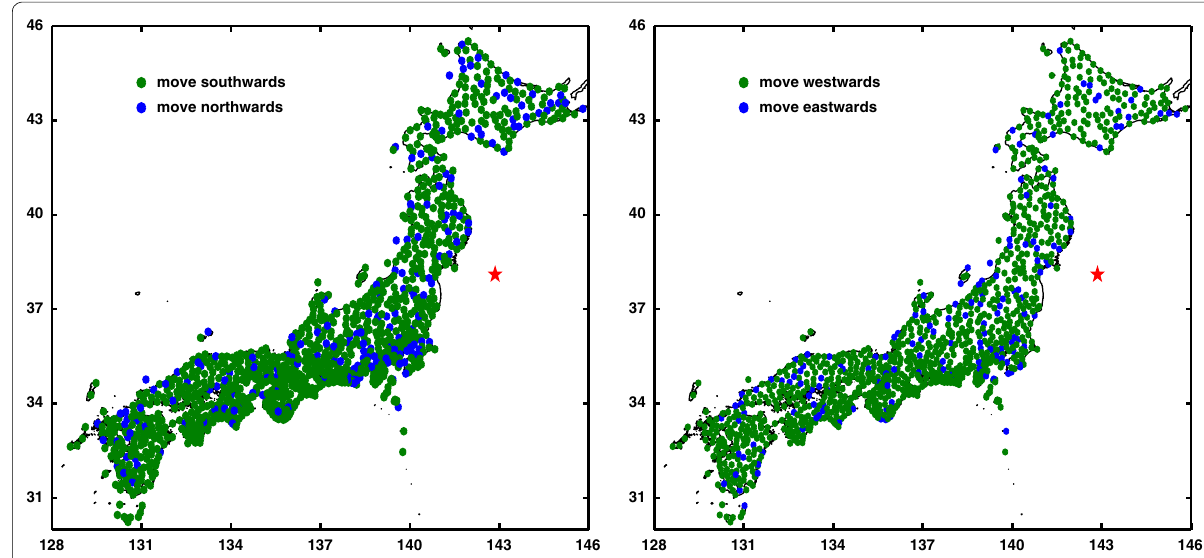
Fig. 8 The patterns of the movements of 1198 GEONET stations within 1 s: left panel—epoch between 15:01:04 and 15:01:05 with 1008 stations moving southward, and right panel—epoch between 15:03:39 and 15:03:40 with 1029 stations moving